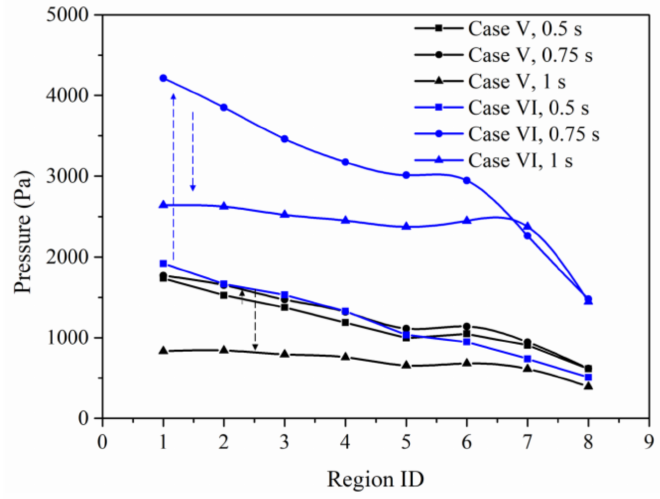
Figure 15. Average pressure distribution along the flow direction in case V (slug injection) and case VI (slug injection).